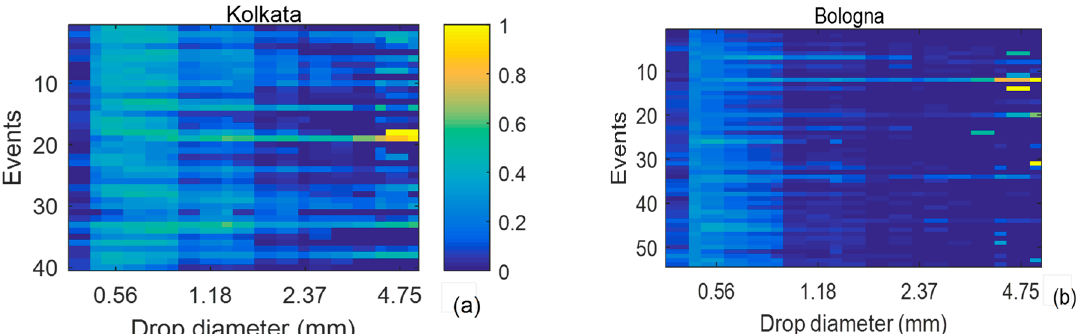
Figure 10. The fractions of sub-terminal drops in the rain events in ( a ) Kolkata and ( b ) Bologna. The color bar represents the fraction of drops. The x-axis represents the drop diameters binned by Parsivel2 classes, whereas the y-axis shows the different events for each site.